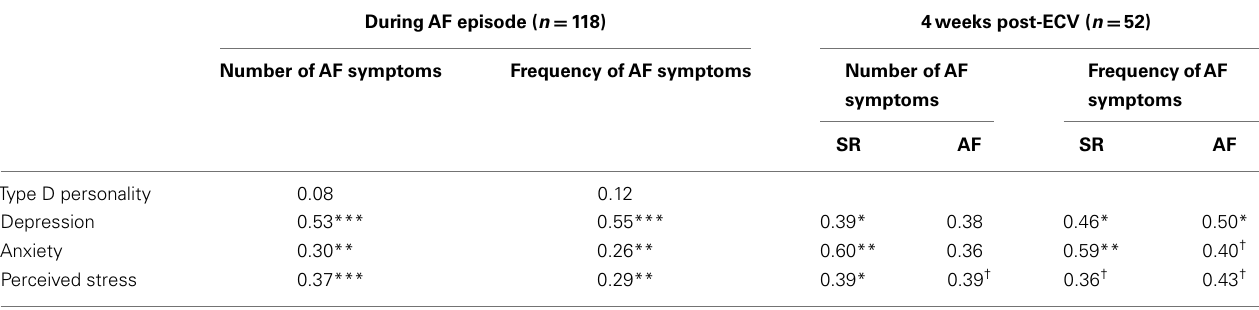
Table 4 | Relation of emotional distress with the number and frequency of reportedAF symptoms during theAF episode and 4weeks post-ECV.